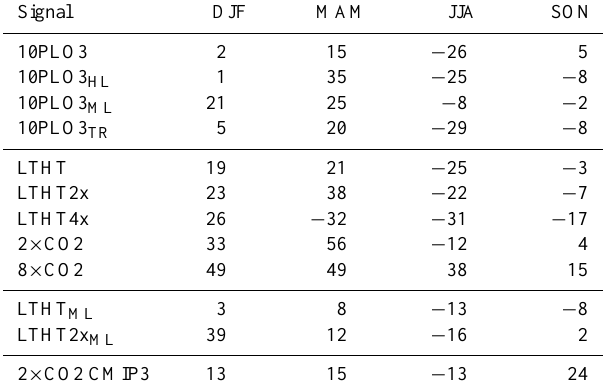
Table 6. Northern Hemisphere 850–20hPa percent change in wave refraction for the (top) stratospheric cooling experiments and (bot- tom) global warming experiments. Also included is the mid- latitude, lower tropospheric heating experiments (LTHT ML and LTHT2x ML ), as well as the ensemble mean CMIP3 2 × CO2 wave refraction. Wave refraction is estimated as the meridional compo- nent of EP flux divided by the vertical component. A more positive value indicates more equatorward wave propagation.